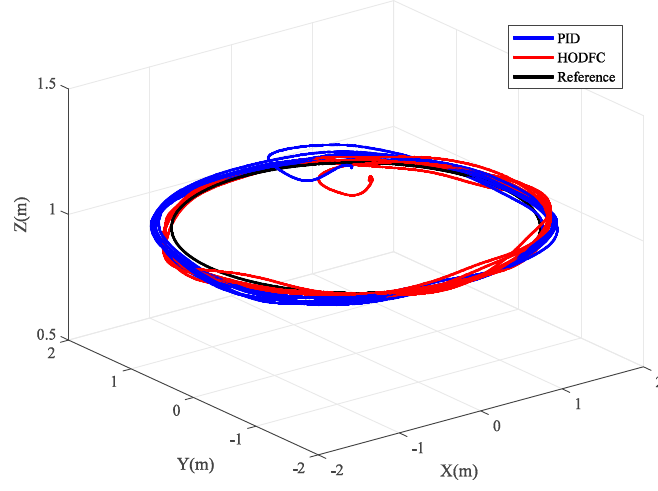
Figure 13. Experimental results of 3D trajectory tracking.